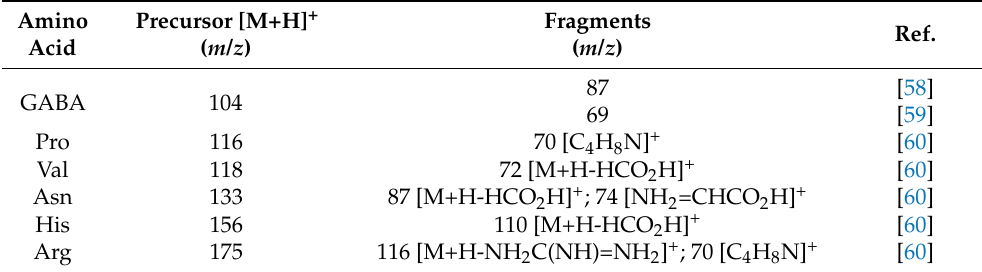
Table 4. Fragmentation data obtained by positive ESI-MS/MS infusion experiments in daughter scans for the precursor ions assigned to γ -aminobutyric acid (GABA), proline (Pro), valine (Val), asparagine (Asn), histidine (His) and arginine